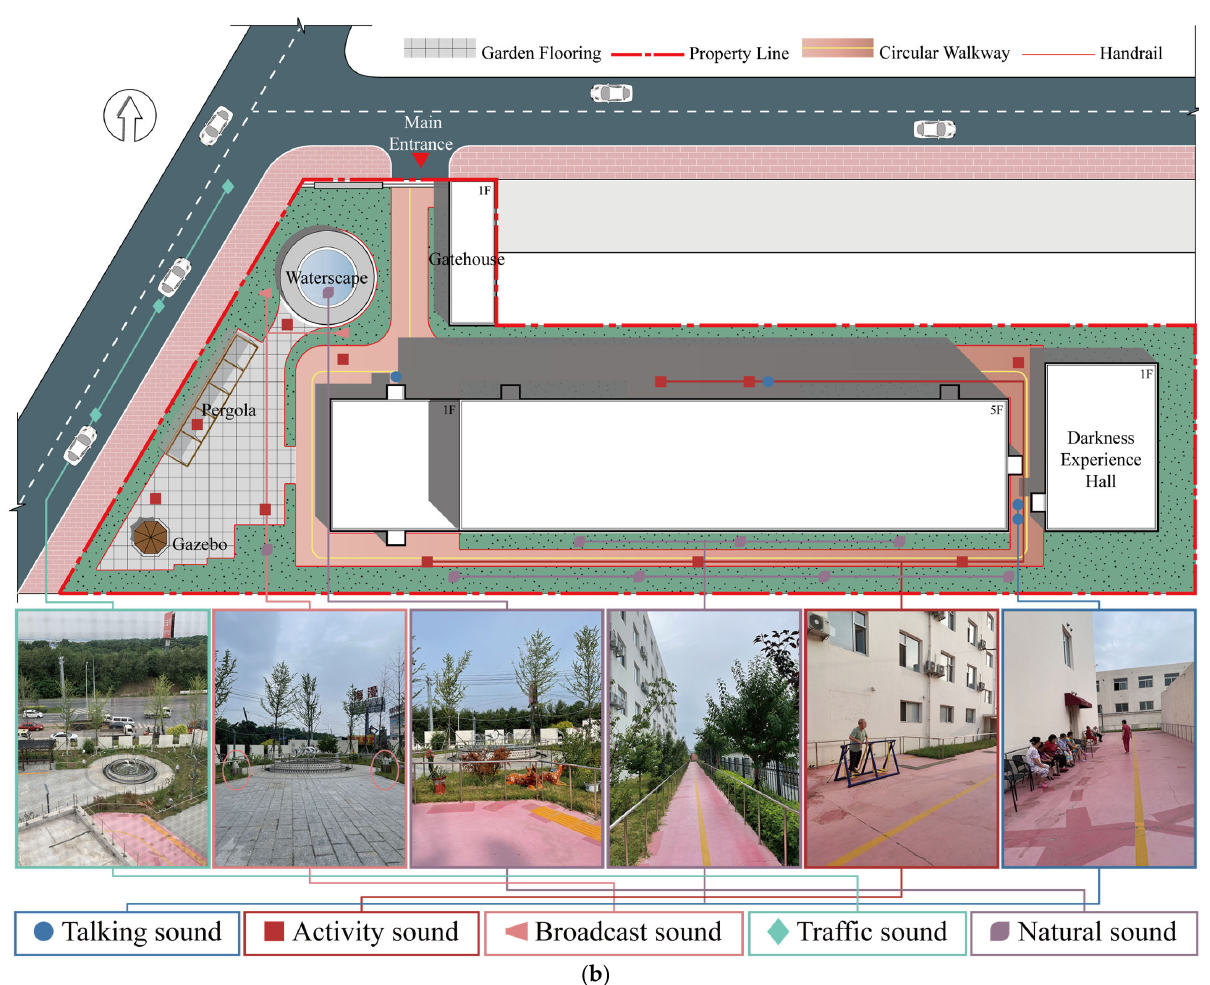
Figure 5. ( a ) Indoor sound sources in the nursing home; ( b ) outdoor sound sources in the nursing home.